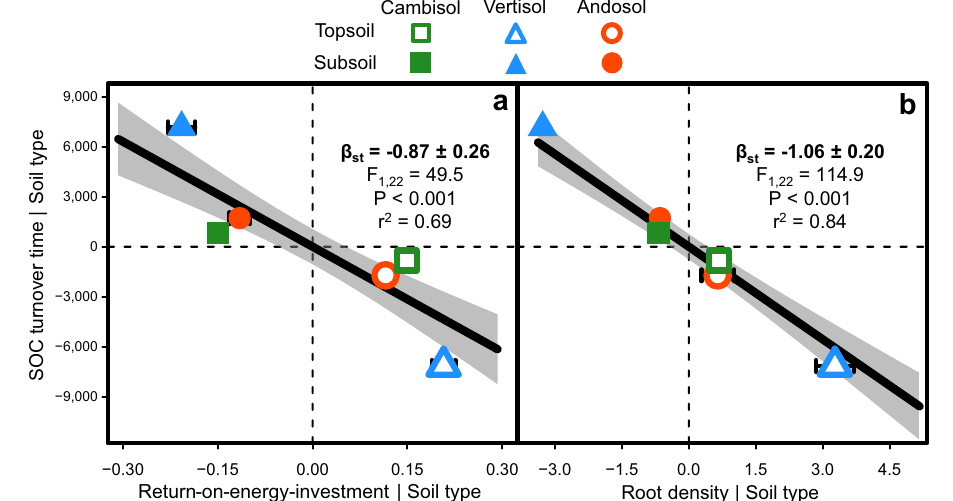
Fig. 2 | Energy quality and root density as drivers of the depth-dependency of soil carbon dynamics. Partial regression plots relating the depth variation in the turnover time of soil organic carbon (SOC) with those of the return-on-energy- investment parameter ( a ) and root density ( b , n =24 soil cores). The residuals of linearmodels fi ttingeachvariablewith ‘ soiltype ’ asa fi xedeffectwereusedhereso that each variable was normalised for variation across soil types. The return-on- energy-investment parameter was calculated as the ratio between the energy